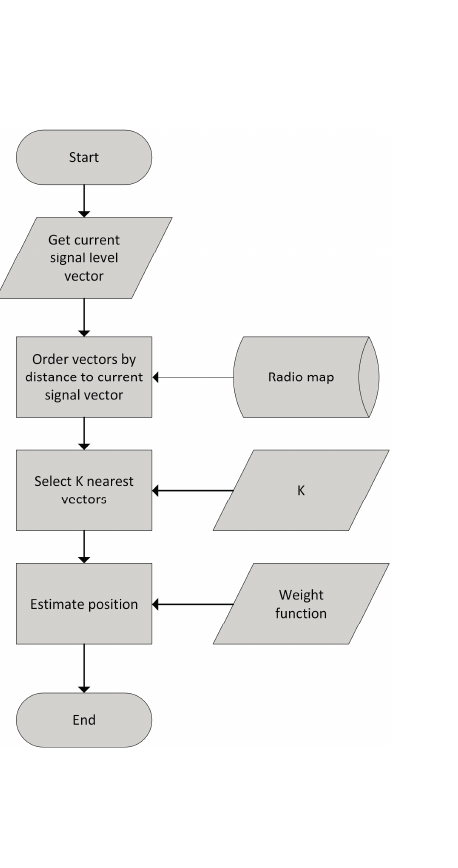
Figure 5. Flowcharts of the basic fingerprinting ( a ) and fingerprinting with 2-phase map reduction algorithm ( b